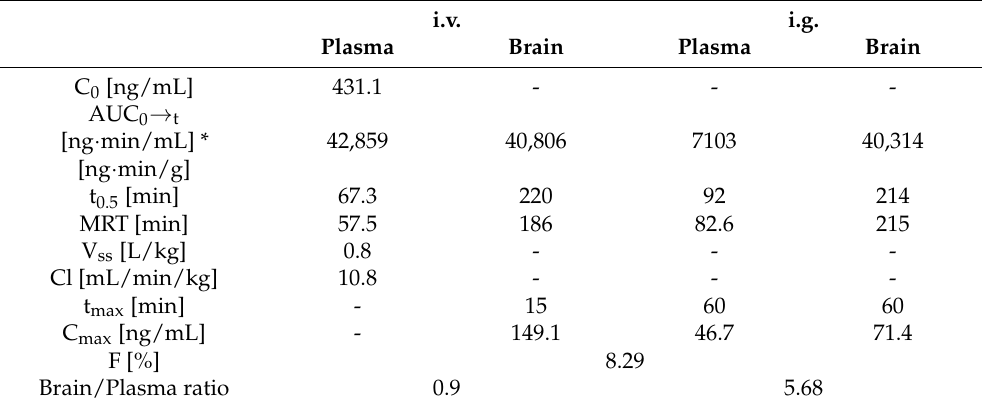
Table 2. Pharmacokinetic parameters and brain uptake for PQA-AZ4 after i.v. and i.g. administration at a dose of 0.5 and 2 mg/kg to male rats, respectively.